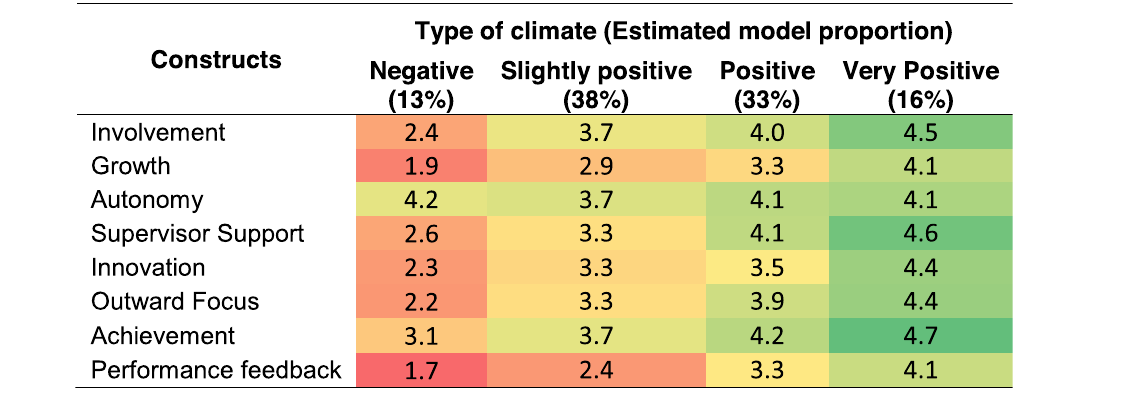
Table 6 Estimated model proportions and estimated means for the VEI model ( n = 166). The color coding in the table represents the average level of agreement on items within the construct, red indicating strong disagreement and green indicating strong agreement